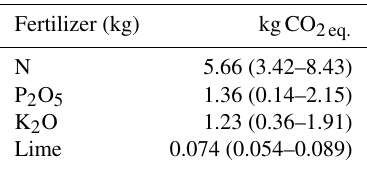
Table 9. Examples for emissions during production of fertilizers (kgCO 2eq . kg − 1 product; Kool et al.,